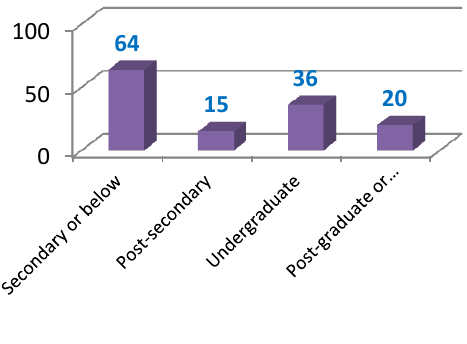
Figure 4. Highest Education Attended